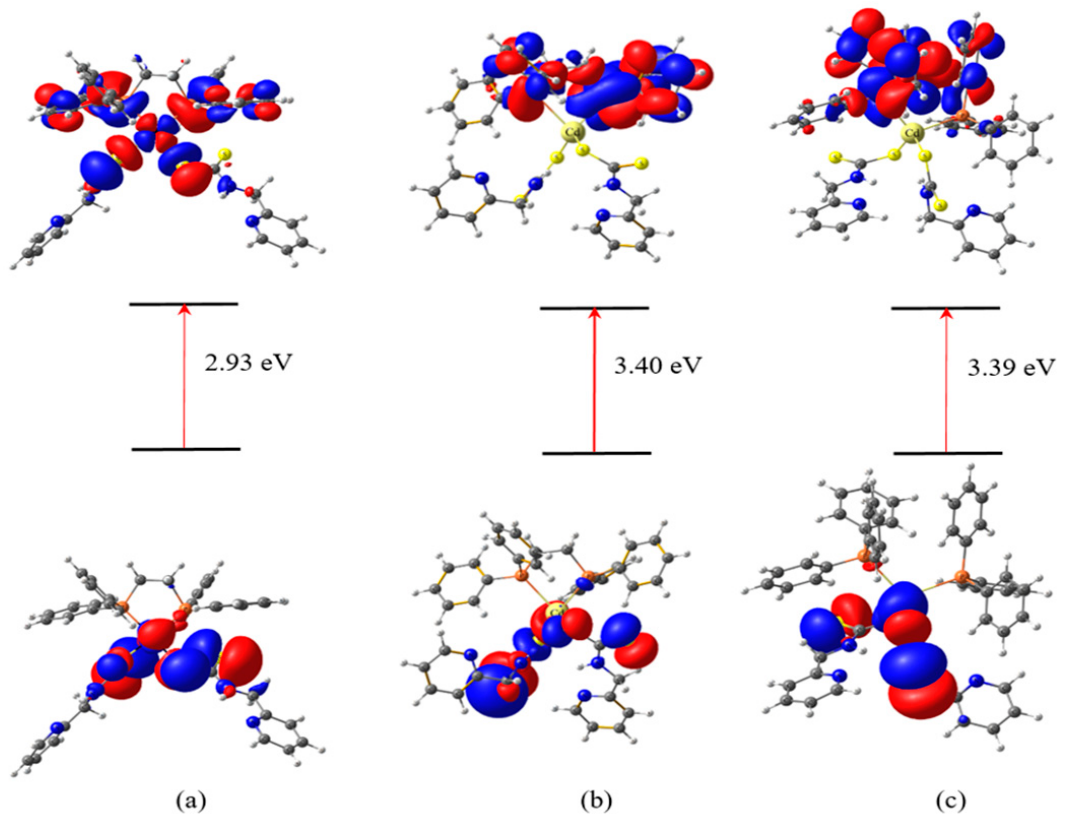
Figure 4. HOMO and LUMO for ( a ) Pd(1), ( b ) Cd(2) and ( c ) Cd(7). Table 5. Second order perturbation energies for charge transfers from donor to acceptor orbitals in Pd(1)